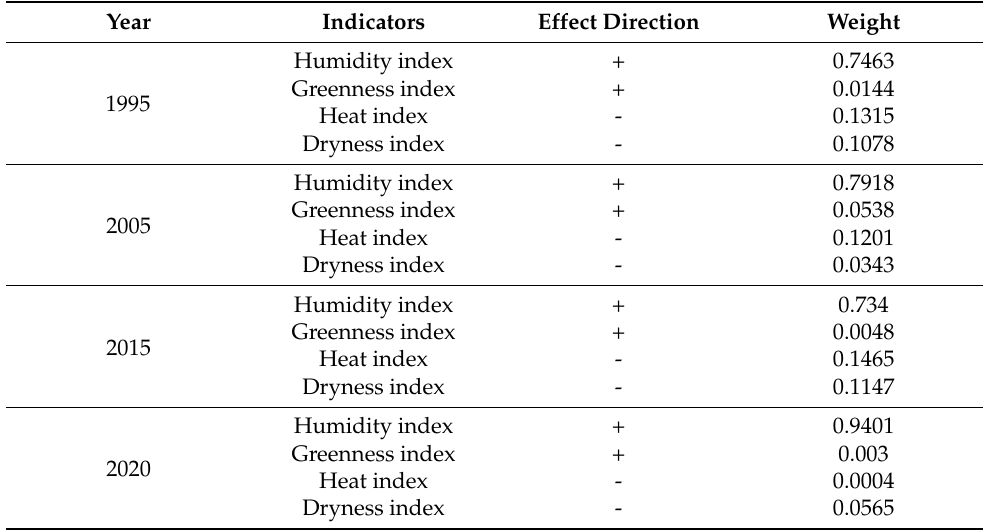
Table 3. Weights of